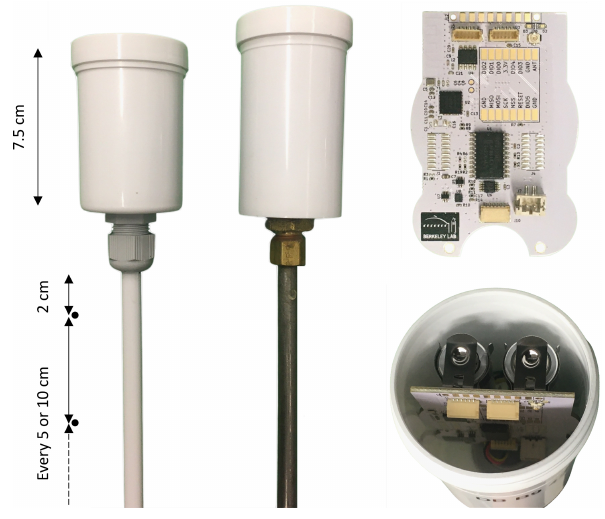
Figure 1. General overview of the DTP system. The DTP system can be assembled in various lengths with temperature sensors every 5 or 10cm along the probe and packaged in a plastic or stainless- steel tube, depending on deployment goals and environmental con- ditions. The data logger controls the temperature sensors on the probe, sequentially reading and storing the temperature data. An Android app is used to communicate with the logger and download data